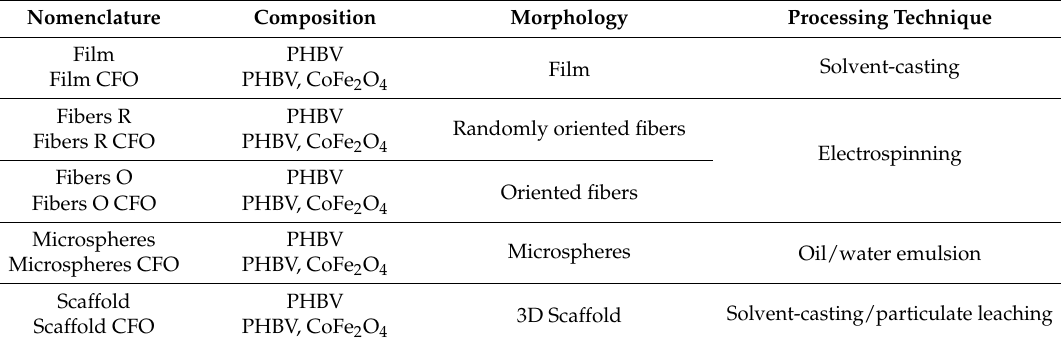
Table 4. Procedures for the processing of PHBV and PHBV/CFO composites into different